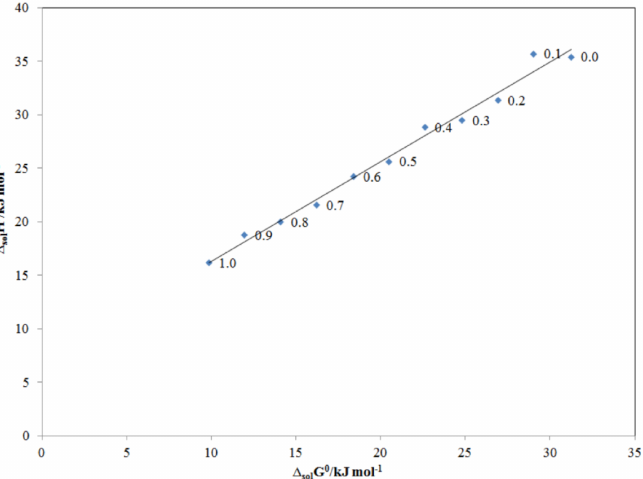
Figure 8. ∆ sol H 0 vs. ∆ sol G 0 enthalpy–entropy compensation plot for the solubility of TRV in various PG + water compositions at T hm = 308